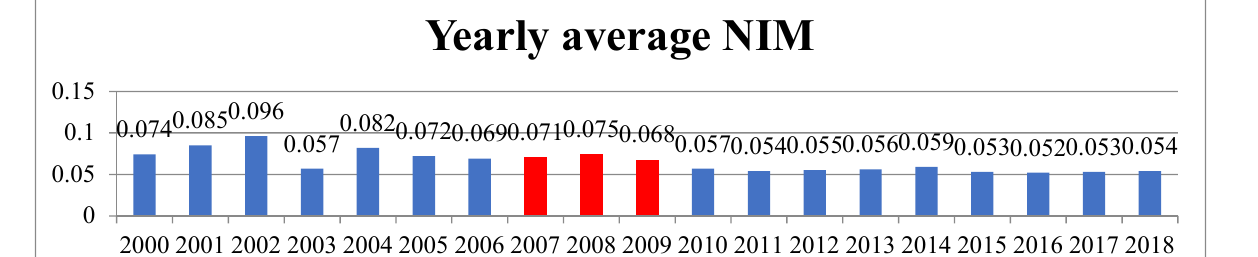
Figure 1. The average annual net interest margin of EEs’ banks.